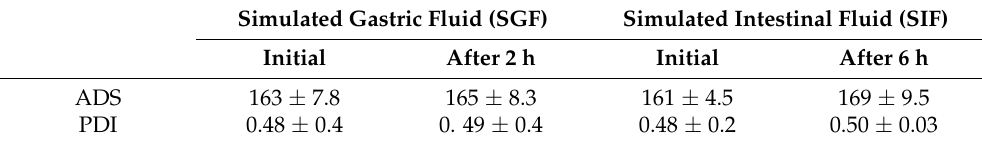
Table 6. Stability of tadalafil-loaded self-nanoemulsifying chewable tablets (SNECT) in GI fluids.